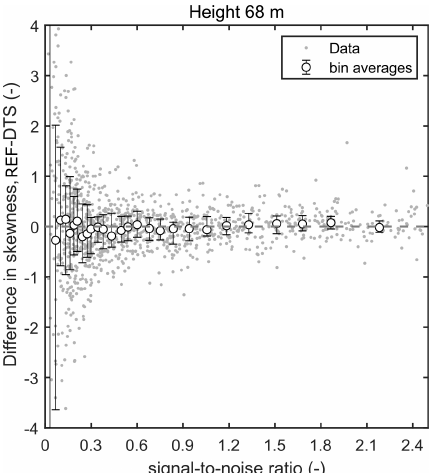
Figure 6. Difference in temperature skewness calculated from 3D sonic anemometer (REF) and DTS as a function of DTS signal- to-noise ratio (Eq. 13). Individual 30min values (grey dots), bin medians (circles) and the interquartile range (error bars) are